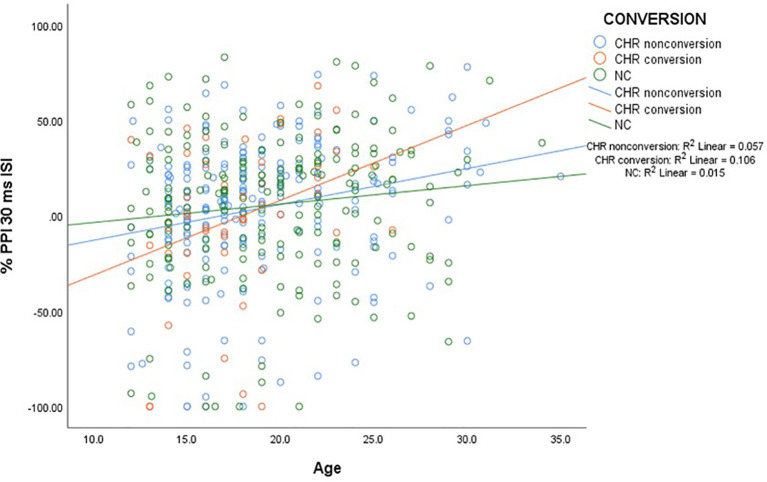
The figure shows a scatter plot of the significant age correlations with PPI in CHR converters, non-converters and NC participants. There were significant correlations within the CHR but not the NC participants. The CHR participants who converted to psychosis had the largest correlations with age.